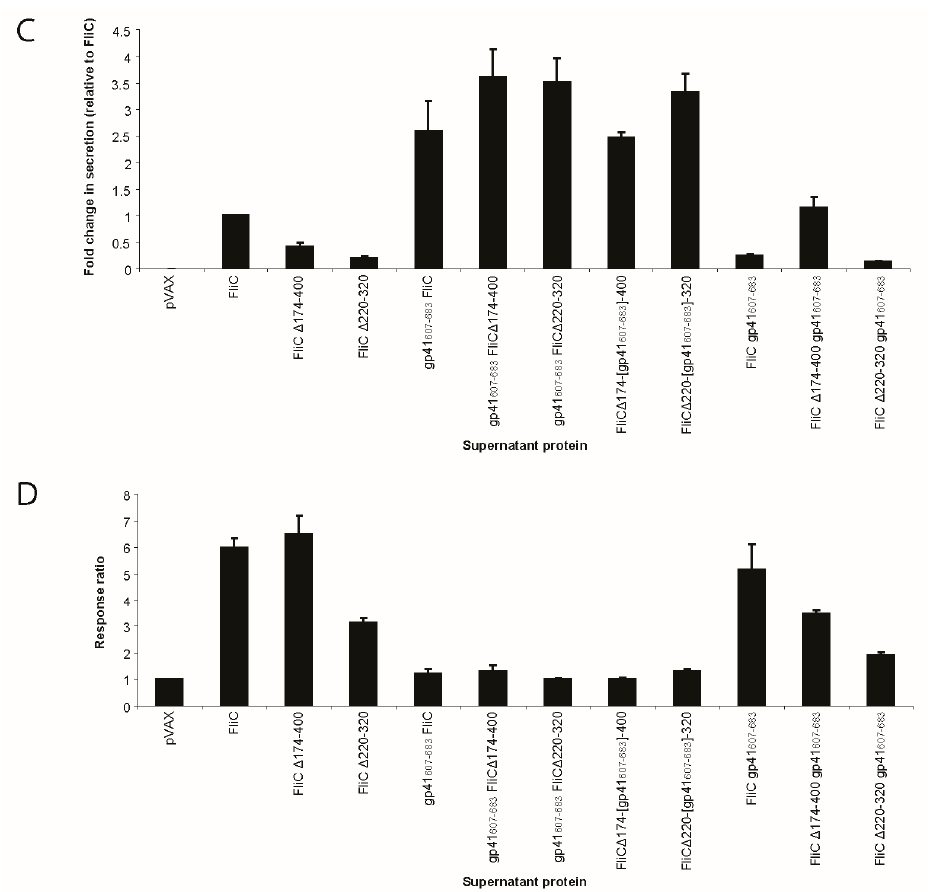
Figure 4. FliC Δ 174-400 with gp41 607-683 inserted at its N-terminus is secreted and maintains